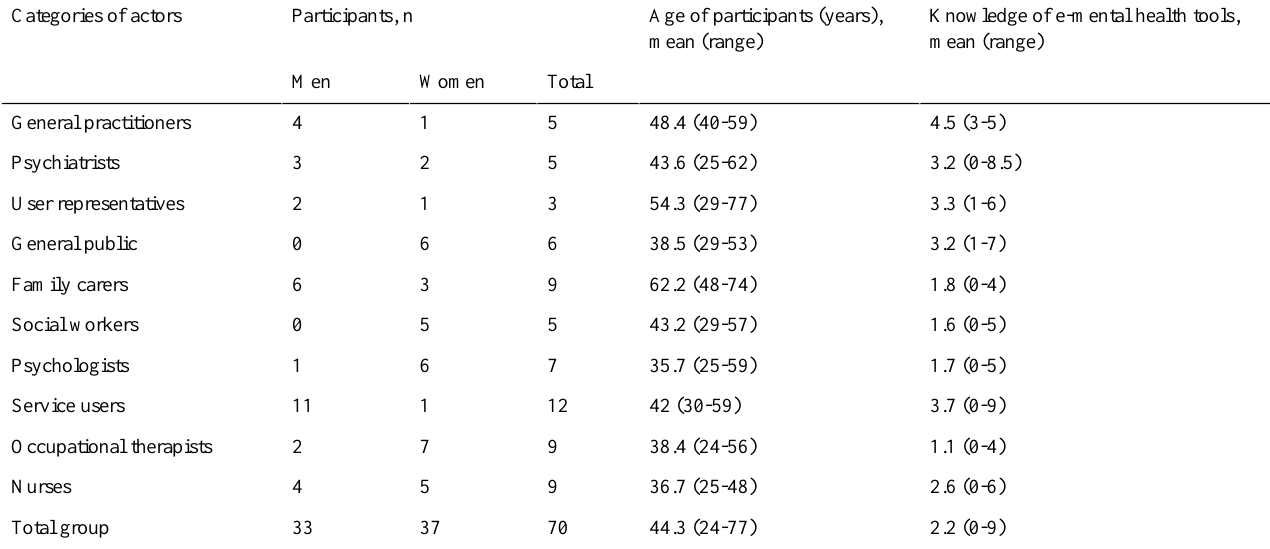
Table 1. Participants’characteristics and self-assessment of eHealth knowledge.